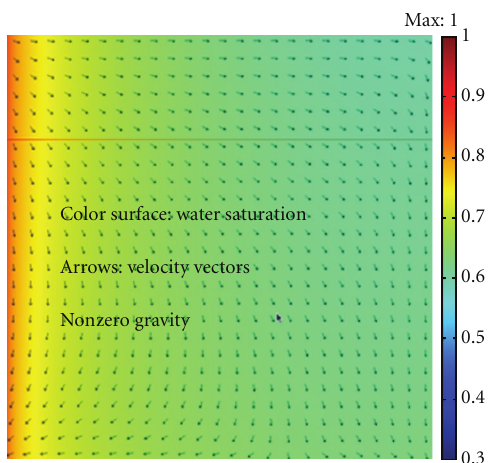
Solid lines: Zero gravity Dashed lines: Non-zero gravity Figure 4: Comparison between considering and neglecting gravity